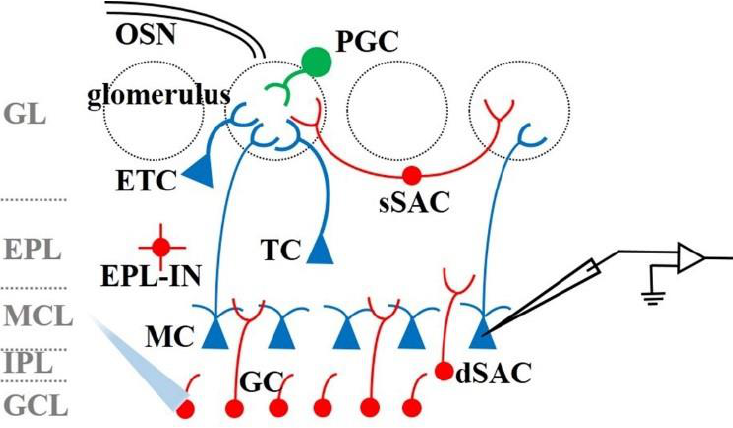
Figure 3. Schematic diagram of the structure of the OB. The method of using optogenetics to study interglomerular interactions is to activate specific interneurons, and then record the electrophysiological signals of M/T cells.